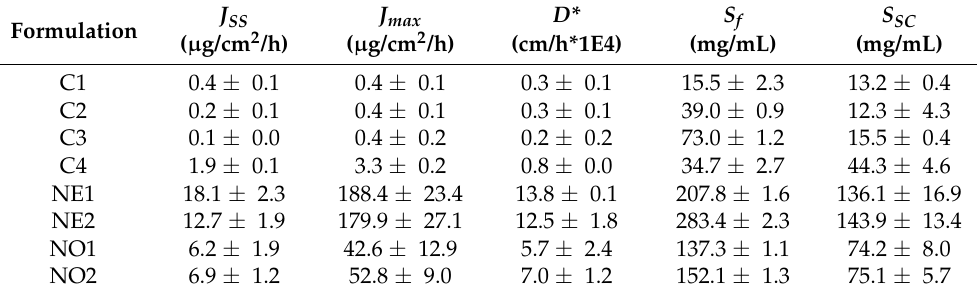
Table 3. Experimental data for minoxidil in different nanoemulsions and control vehicles. (Mean ± SD). The nanoemulsions containing penetration enhancers eucalyptol (NE1 and NE2) and oleic acid (NO1 and NO2), and the control solutions (C1–C4), are defined in Table 1. J SS J max D* S Formulation